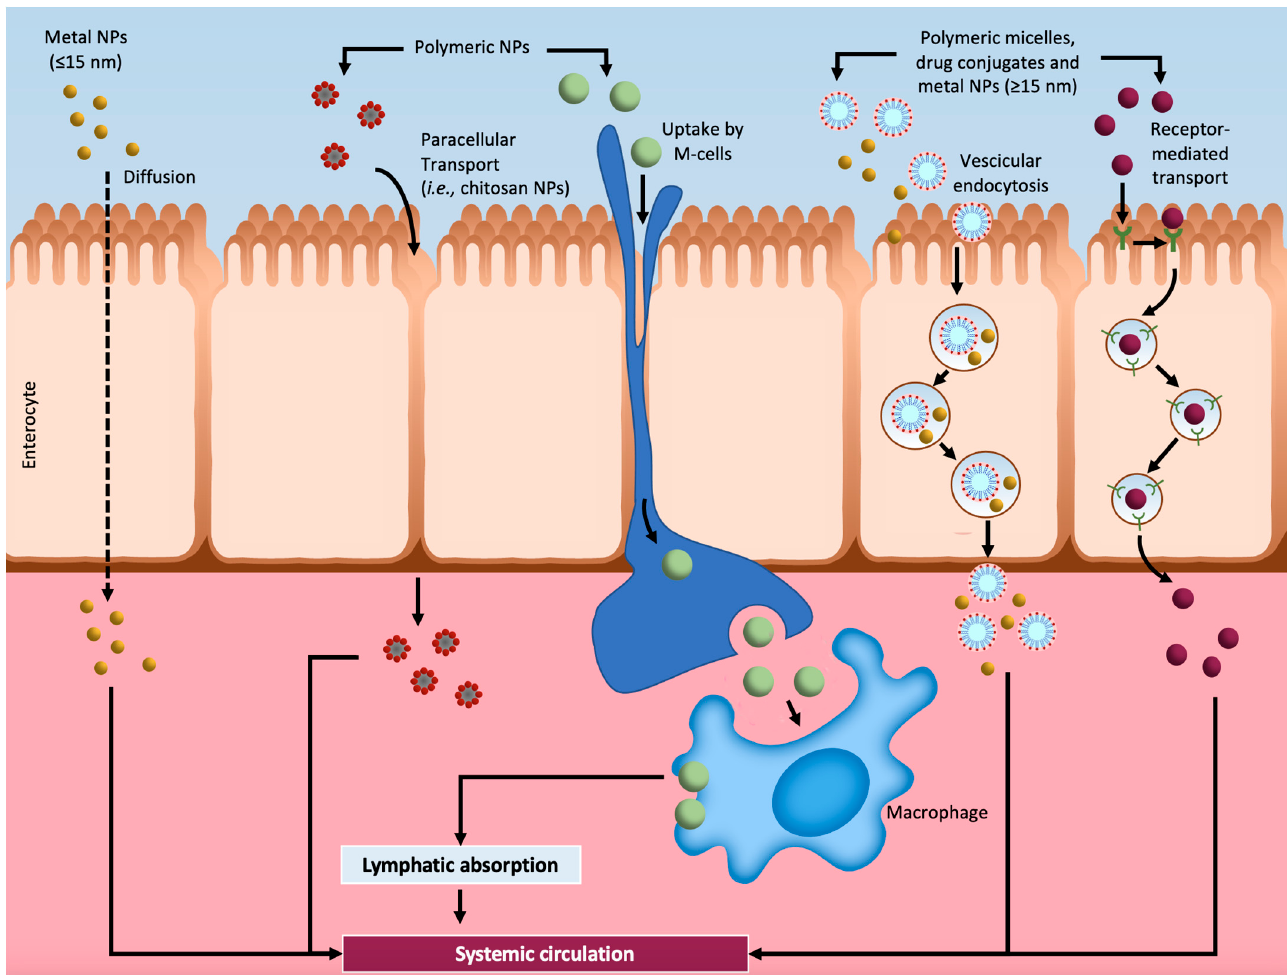
Figure 2. Nanocarriers uptake. The picture reports the general uptake of nanocarriers in the gastrointestinal tract (which is the main target for several nanoparticles that involves oral administration) (adapted from the works in [75,76,78,84]).